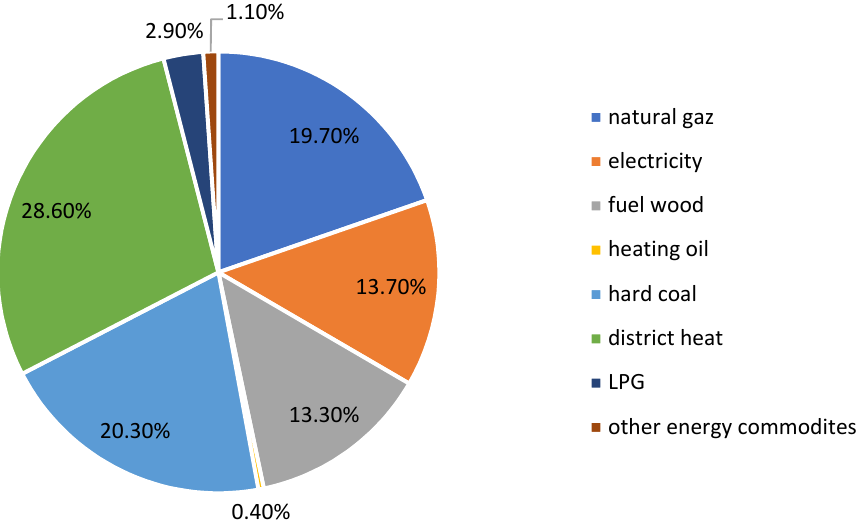
Figure 2. Structure of energy consumption in households per capita, broken down by individual energy carriers in 2021.